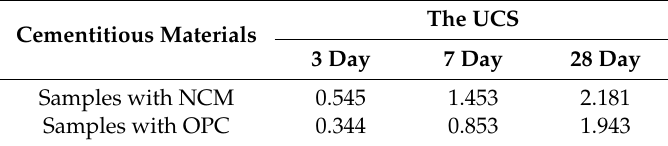
Table 6. The results of UCS with OPC and new cement-based material (NCM). Cementitious